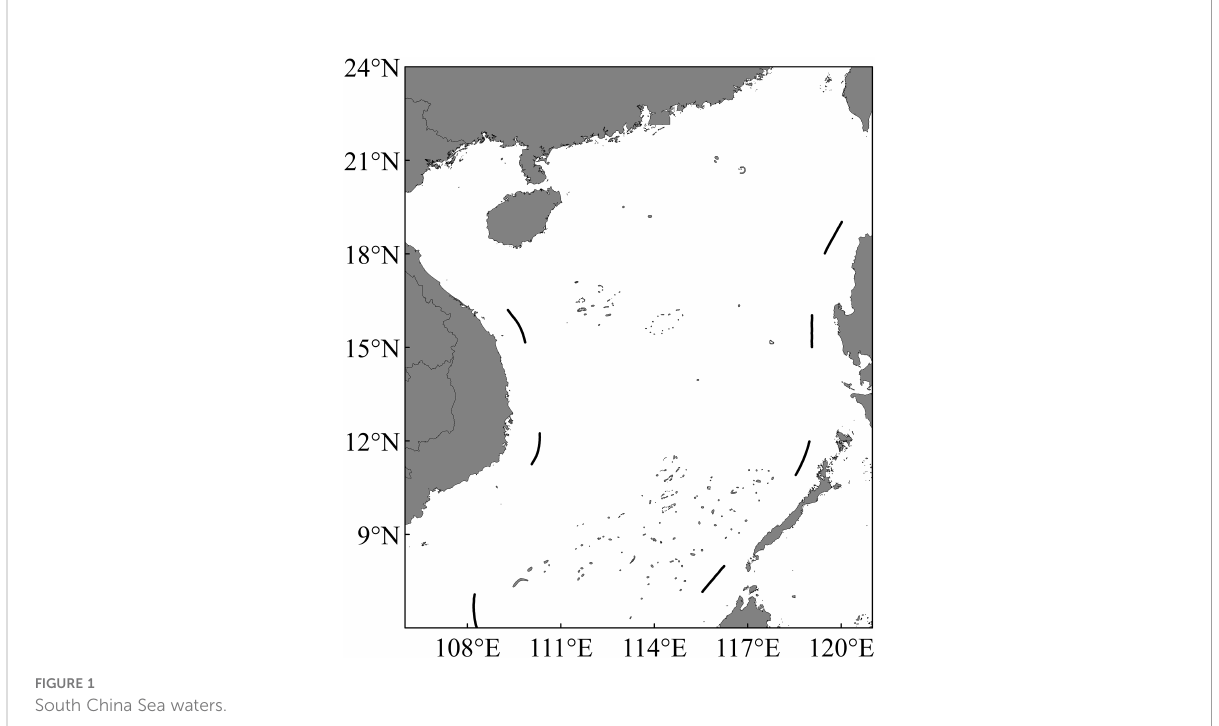
FIGURE 1 South China Sea